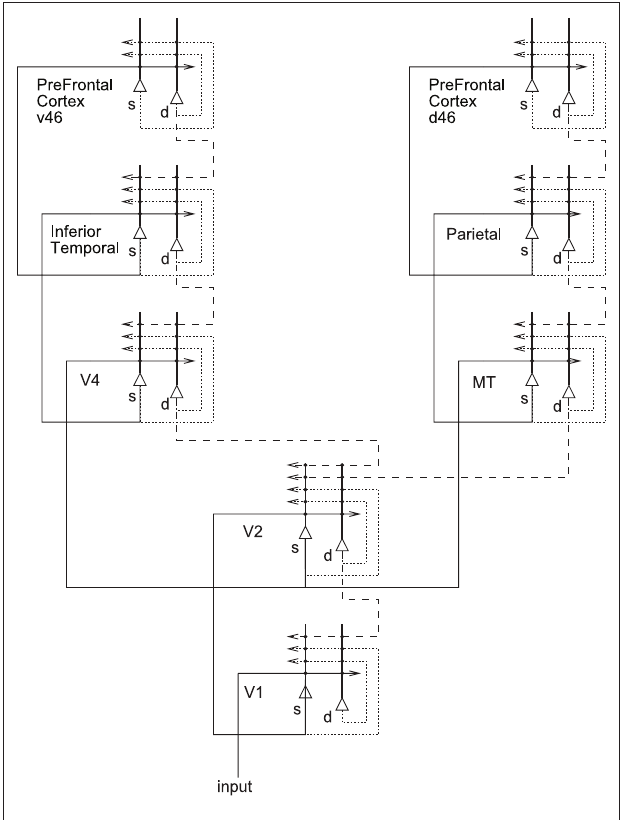
Figure 4 | System-level architecture of a model of the cortical mechanisms of visual-attention and memory. The system is essentially composed of six modules which model the two known main visual pathways of the primate visual cortex. Forward connections are indicated by solid lines; back-projections (which could implement top-down processing) by dashed lines, and recurrent connections within an area by dotted lines. s, Superficial pyramidal cells; d, deep pyramidal cells. Figure modified from Deco and